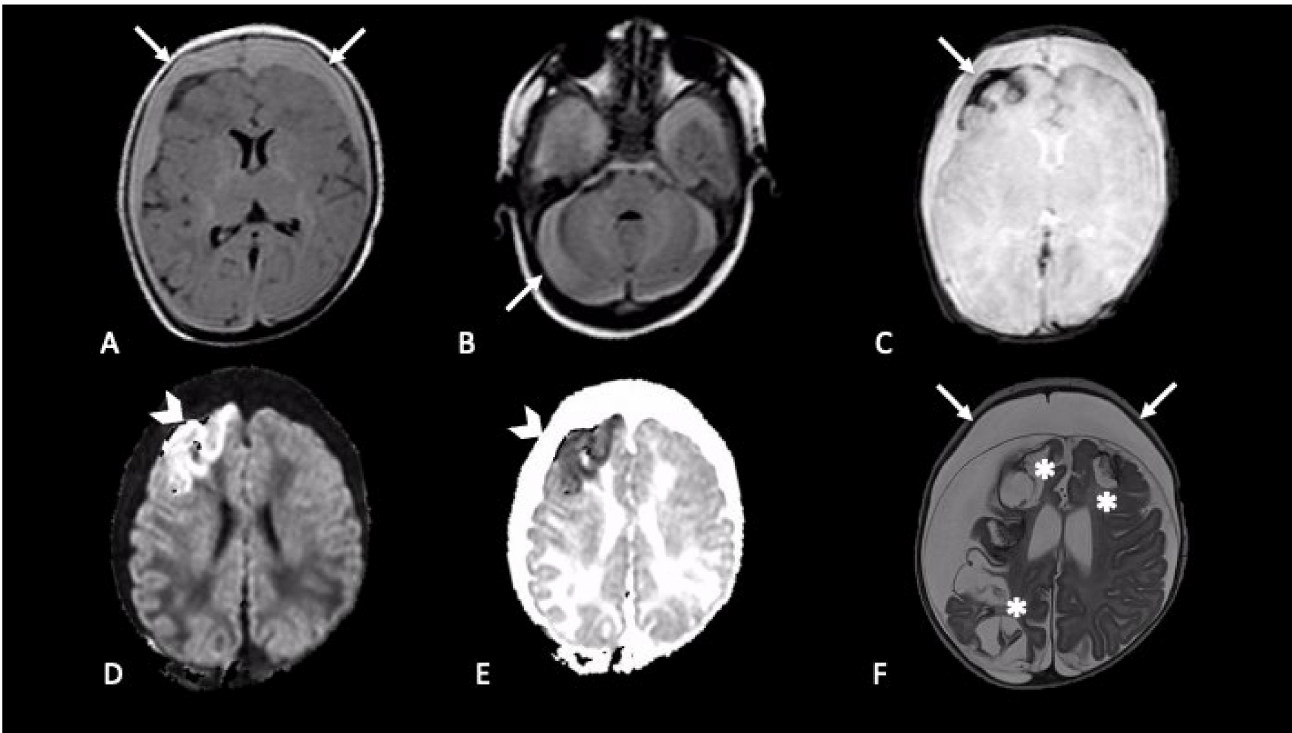
Figure 2. Newborn first accessed in the emergency department with fever and vomit, then was hospitalized four days later due to generalized seizures. CT showed mixed-density bilateral fluid collections (not shown). MRI demonstrated bilateral subdural CSF-blood collection, supra- and infra-tentorial ( A , B axial FLAIR, arrows); subarachnoid blood products are revealed by susceptibility weighted imaging in right frontal lobe ( C , axial SWI, arrow); intraparenchymal cortical-subcortical hemorrhage in the right frontal lobe ( D , E , axial DWI and ADC map, arrows-head). One-month follow-up MRI ( F , axial T2) showed malacic evolution of intraparenchymal damage (asterisks) and bilateral subdural hygromas